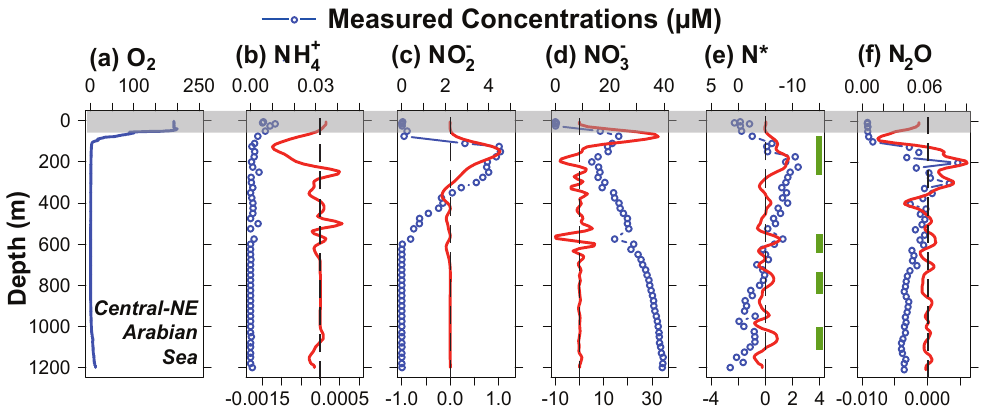
Fig. 4. (a) Vertical distribution of oxygen in the central-NE Arabian Sea (St. 957), along with the corresponding profiles of measured concentrations of inorganic nitrogen, based on which net production (positive) or consumption (negative) rates were modeled: (b) NH + (c) NO − , (d) NO − and (e) N*. In case of (e) N*, positive rates reflect production of more severe N-deficits (i.e. more negative N*). Also 2 3 shown in (f) are the profiles of N 2 O concentrations and modeled consumption/ production from St. 950. Green bars indicate depths at which modeled rates fell within detectable ranges via isotope pairing techniques. The shaded area marks the surface mixed layer, for which the modeled rates should be treated with